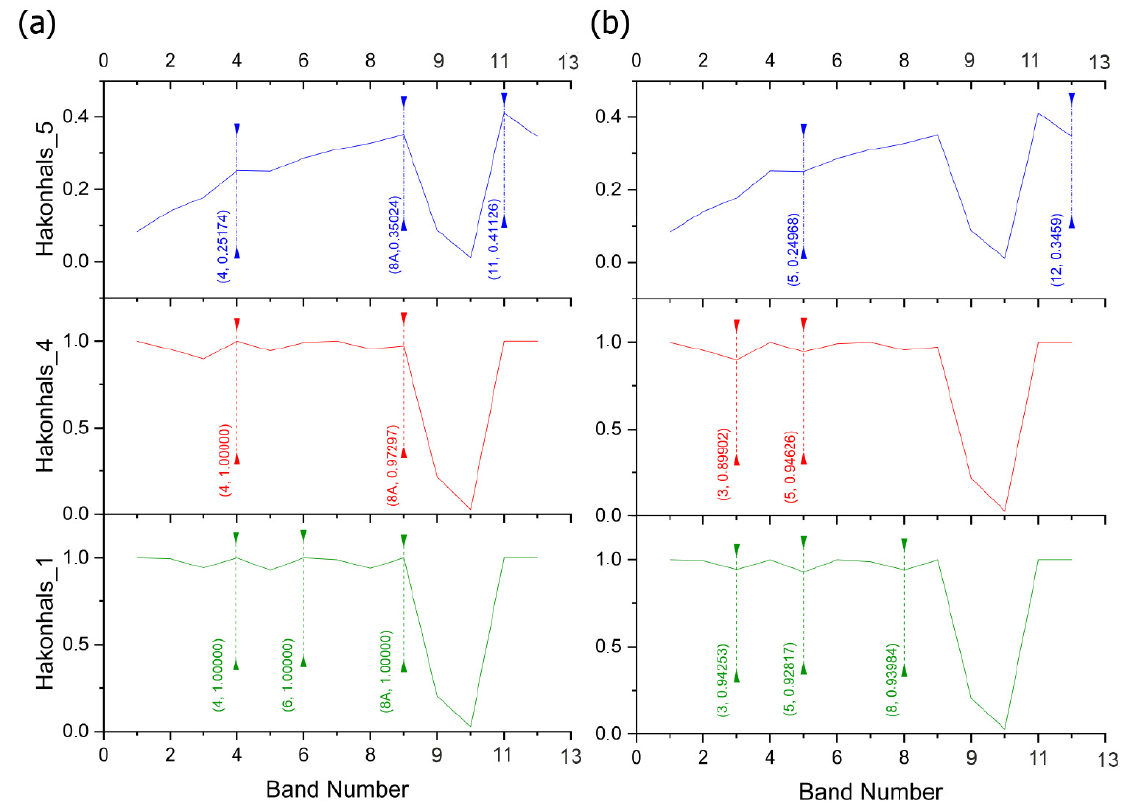
Figure 9. Sentinel 2 spectral behaviour from Håkonhals mine (mining spectra). ( a ) Bands in absorp- tion features. ( b ) Bands in reflectance peaks. For each spectrum, in either absorption or reflectance regions, is presented, between brackets, the number of the Sentinel 2 bands, and the respective re- flectance value.